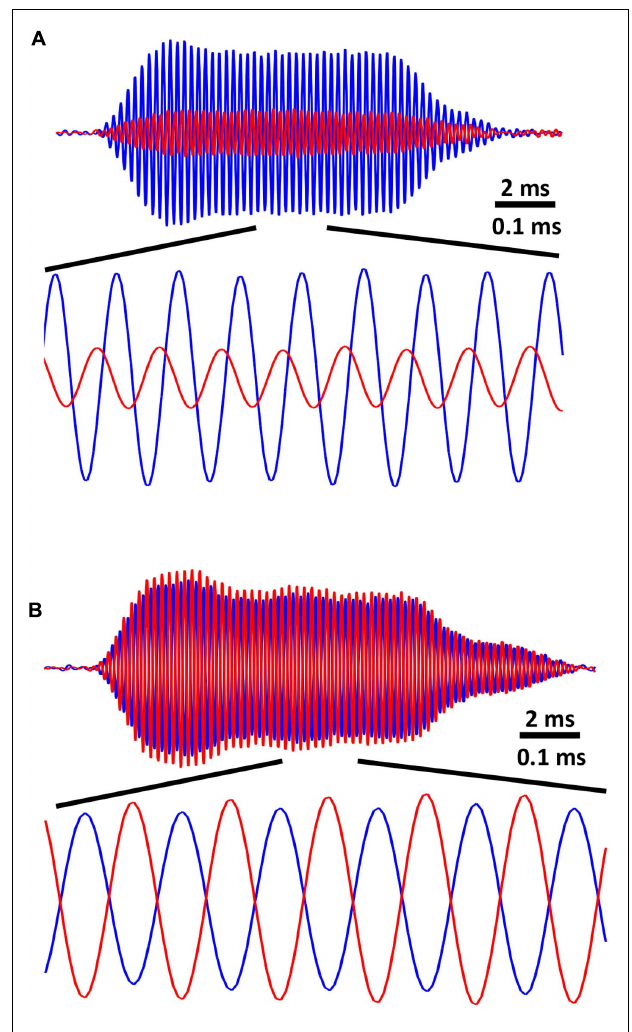
FIGURE 3 | (A) Recorded tympanal vibration (velocity, 6 sweeps averaged) for a sound source located 90 ◦ relative to midline. Ipsilateral (blue) tympanum vibrates with 12dB higher amplitude than contralateral (red), and contralateral tympanal vibration is delayed by 70 µ s relative to ipsilateral. Note that